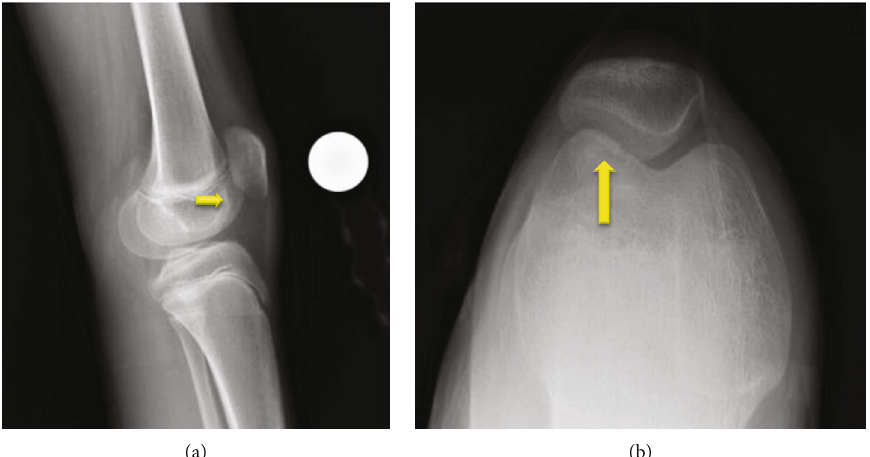
Figure 3: Follow up X-rays of patient with trochlear osteochondritis dissecans (OCD) showing bony healing on (a) lateral and (b) sunrise views of the left